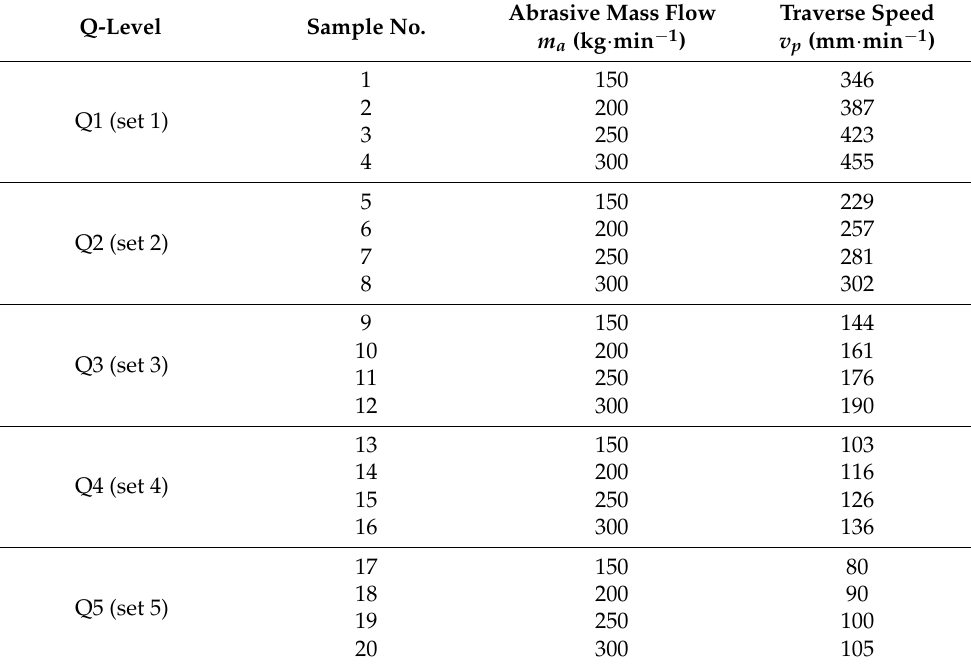
Table 2. Marking of samples (sets based on process